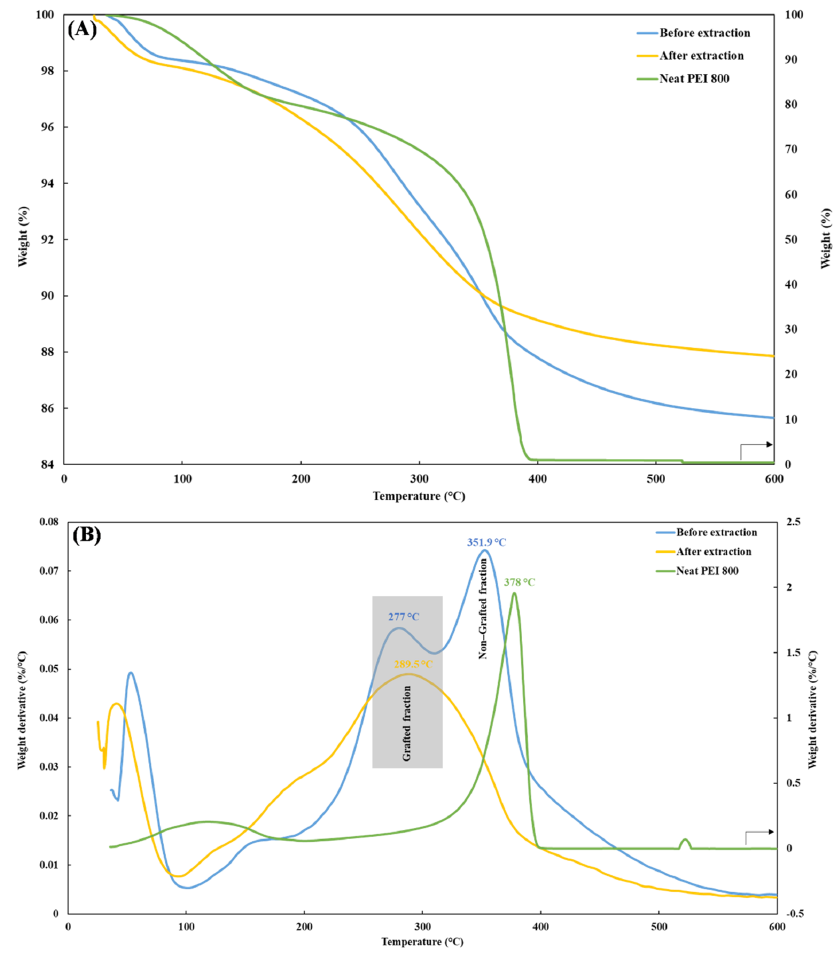
Figure 5. ( A ) TGA and ( B ) DTG thermograms of PEI800/3/2.0 before (blue line) and after (yellow line) extraction and neat PEI 800 (green line).